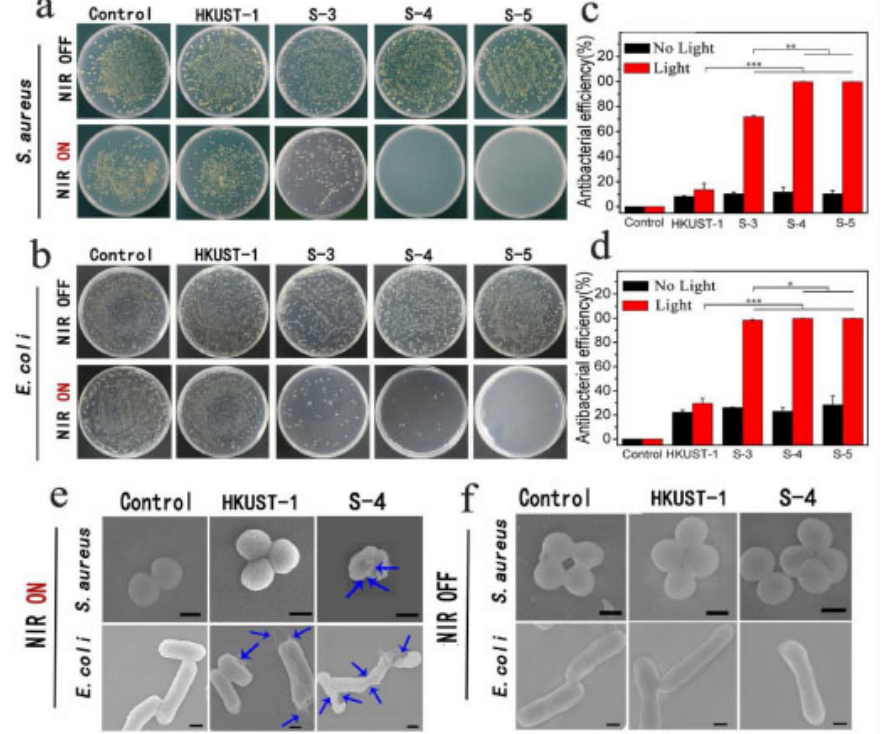
Figure 12. ( a , b ) In vitro antimicrobial studies. ( c , d ) %Antibacterial efficiency of MOFs against E. coli and S. aureus , respectively, error bars show ± standard deviation of * p < 0.05, ** p < 0.01, and *** p < 0.001. ( e , f ) Morphology of E. coli and S. aureus with NIR on and OFF, arrows in ( e ) pointing to the disrupted morphology of E. coli and S. aureus upon irradiation with NIR. Reproduced with permission from [93] .